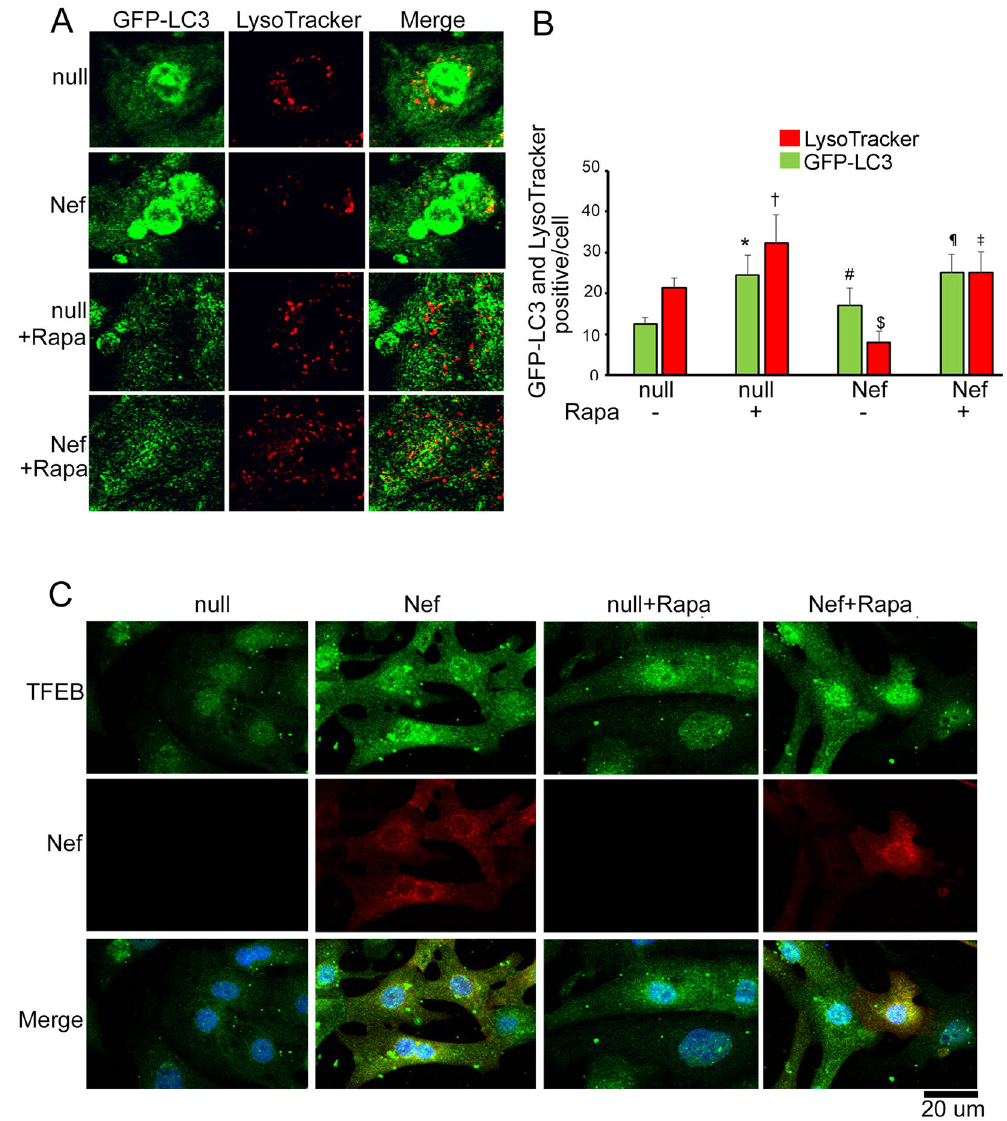
Figure 7. Rapamycin treatment restored the lysosome content of cardiomyocytes. ( A ) NRVCs were transduced with Ad-GFP-LC3 for 48 hours, incubated with LysoTracker (red), and observed by confocal microscopy. Representative image shows the localization of lysosome (red) and autophagy puncta (green) in Nef expressing cells. ( B ) Quantification of lysosomes and autophagosomes in cardiomyocytes (n = 4 wells/ group, * P < 0.05, vs Ad-null; † P < 0.05, vs Ad-null; # P < 0.05, vs Ad-null; $ P < 0.05, vs Ad-null; ¶ P < 0.05, vs Ad- null and Ad-Nef; ‡ P < 0.05, vs Ad-Nef). ( C ) Representative images showed that rapamycin treatment reduced cytosolic accumulation of TFEB protein in Nef transduced cardiomyocytes. NRVCs were transduced with Ad-null or Ad-Nef for 48 hours and treated with rapamycin for 12 hours. Cells were fixed with 4% PFA and immunocytochemistry was done with TFEB (green) and Nef (red) antibodies